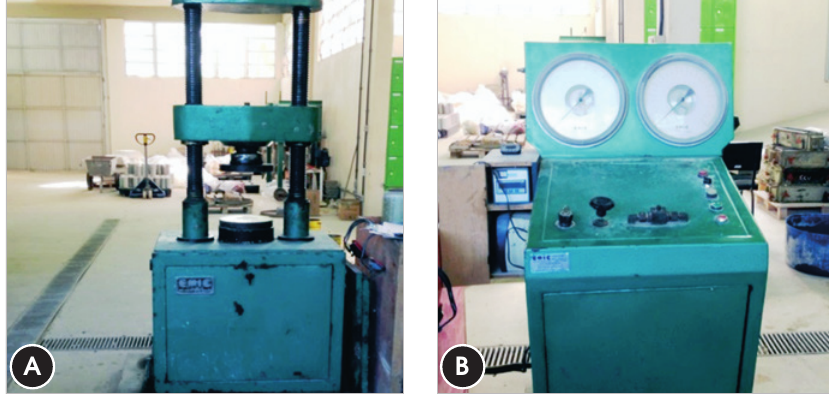
Compression-testing machine EMIC PCE 150